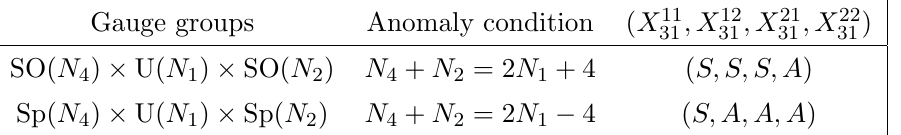
without (cid:13)avour branes. \A" 2